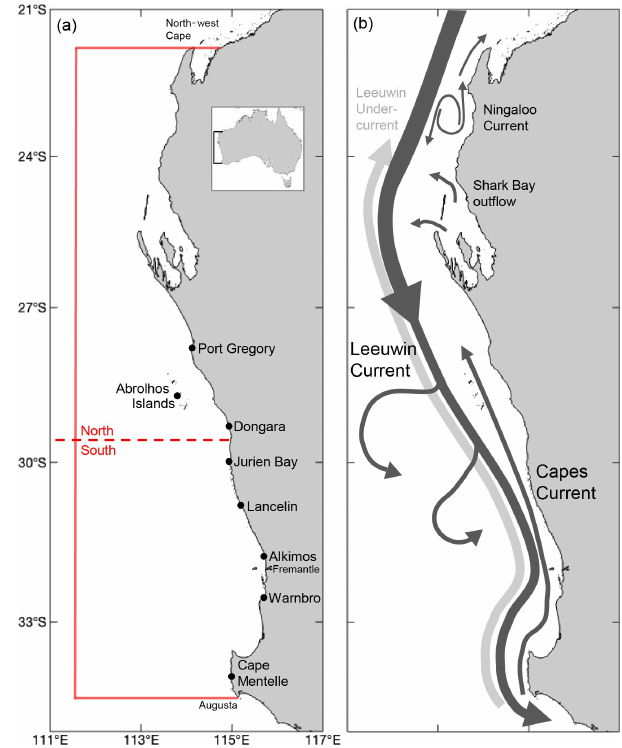
Figure 2. (a) Locations of puerulus survey sites included within this study and other locations of note. The north and south refer to the midpoint used in this analysis. The red boundary is the extent of en- vironmental variables. The inset shows the location of the coastline in Australia. (b) Schematic of the major current systems thought to influence early-stage P. cygnus larvae movement. Relative arrow size and location show characteristic currents. Eddies generated by the LC flow down the continental shelf are also